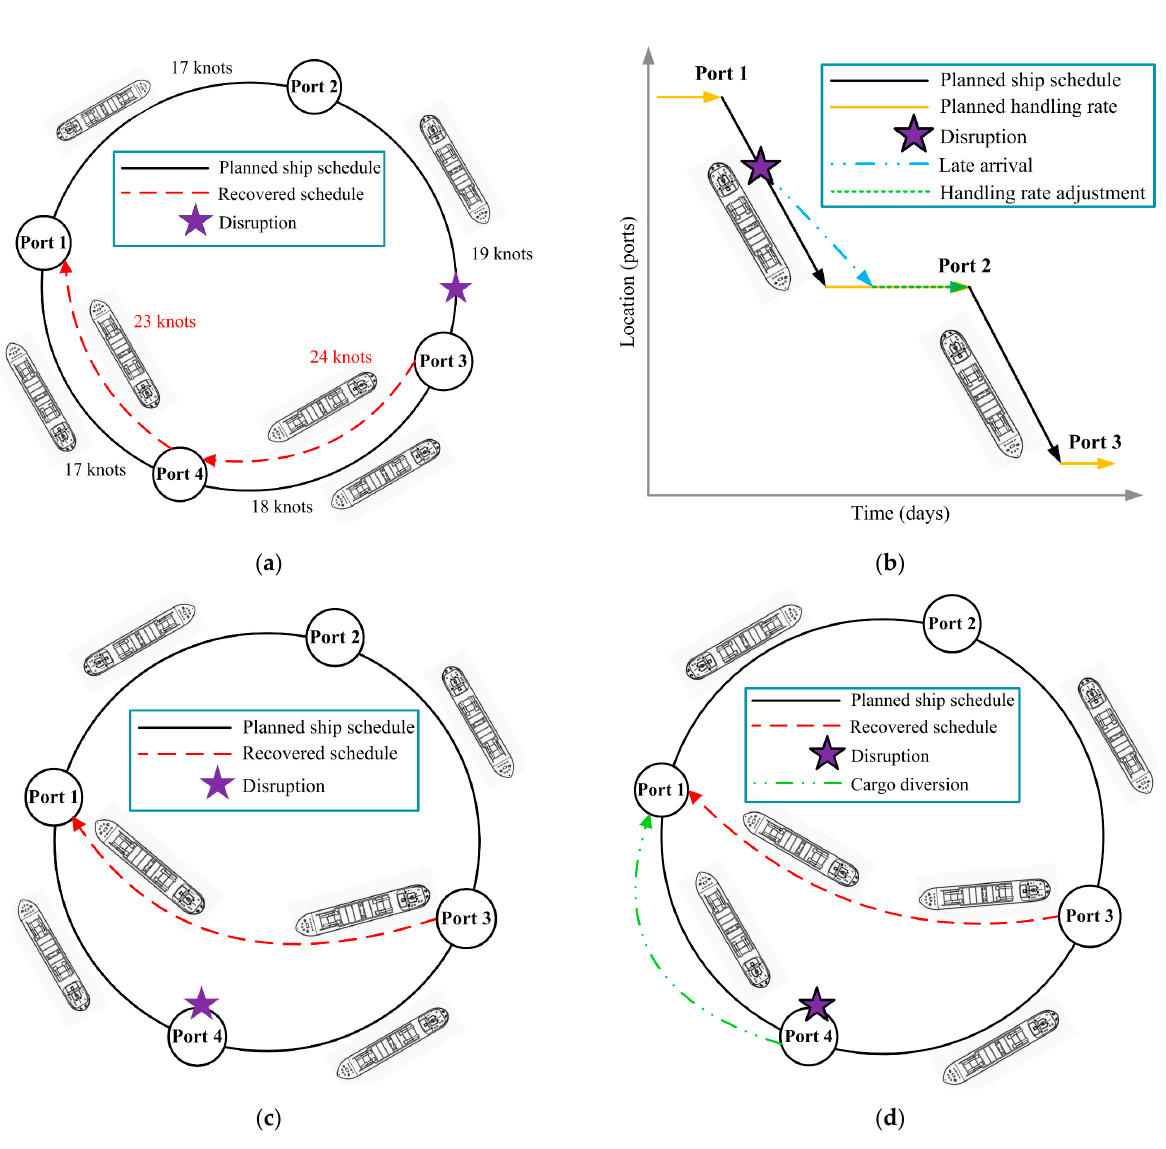
Figure 7. Ship schedule recovery options considered: ( a ) sailing speed adjustment; ( b ) handling rate adjustment; ( c ) port skipping; and ( d ) port skipping and container diversion.